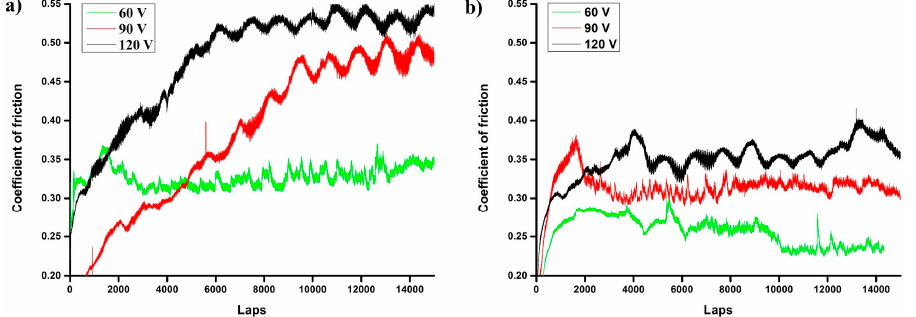
Figure 9. Evolution of the friction coefficient for as-deposited ( a ) and hydrogen exposed ( b ) CrN x coatings as a function of substrate bias. coatings as a function of substrate